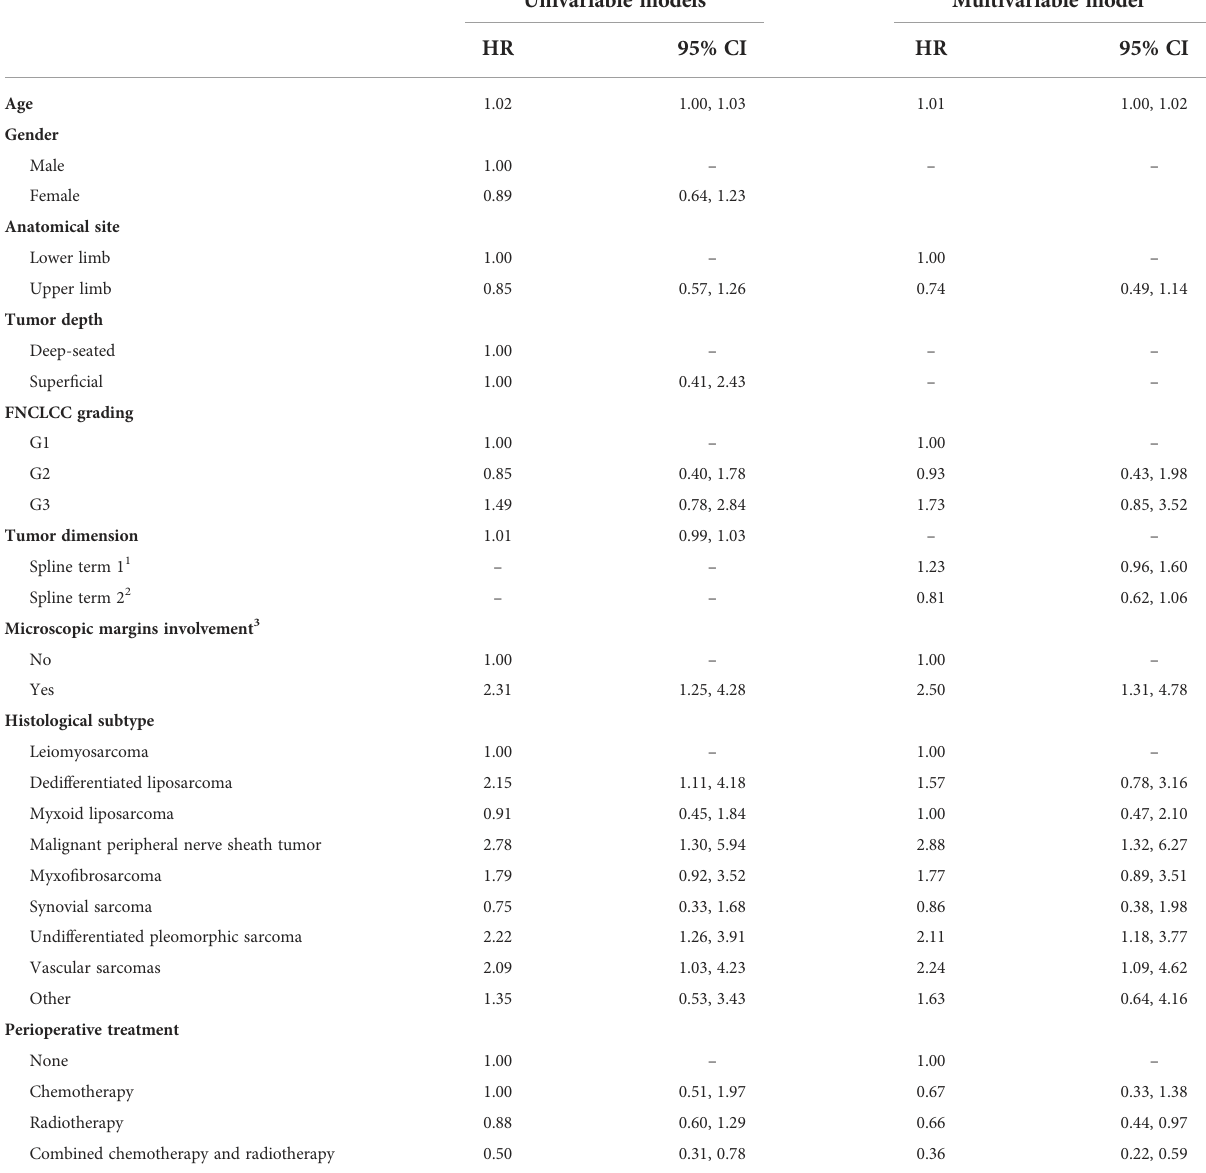
TABLE 3 Hazard ratios and 95% con fi dence intervals from the univariable and multivariable Cox proportional hazards models predicting 10-year local